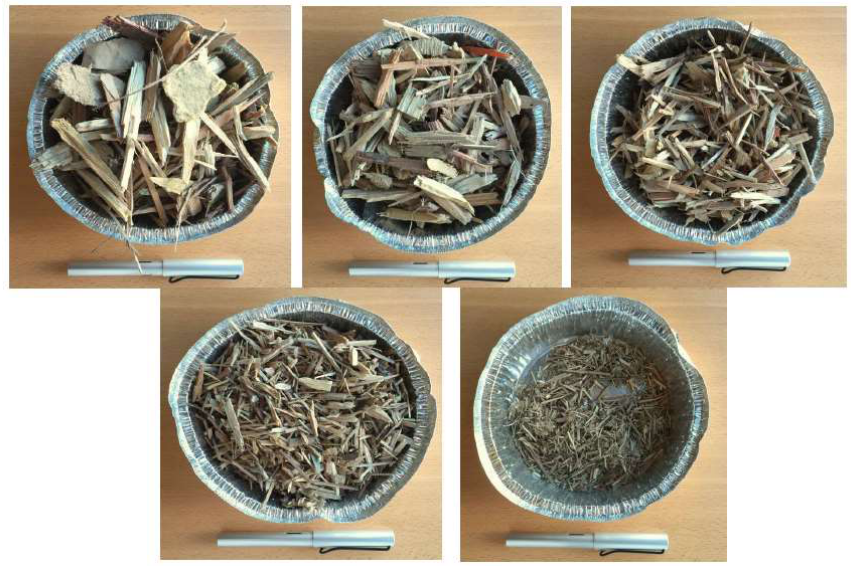
Figure 3. The fuel samples were separated into five sizes. Particle size (x) from the top left to the bottom: x > 25 mm, 12.5 < x < 25 mm, 6.3 < x < 12.5 mm, 3.15 < x < 6.3 mm, and x < 3.15 mm.